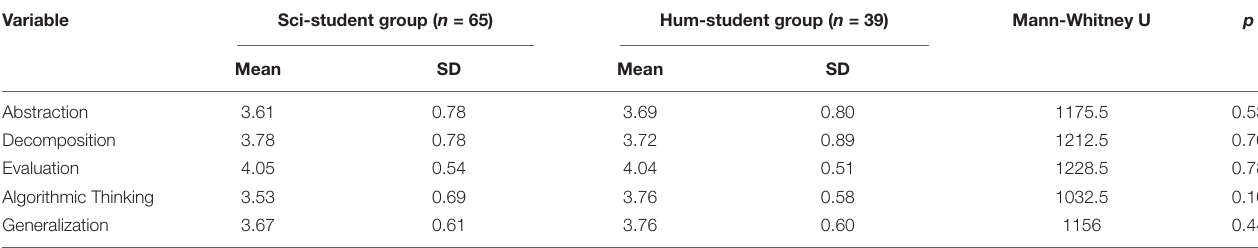
TABLE 4 | Analysis of the between-group differences in computational thinking ability*.